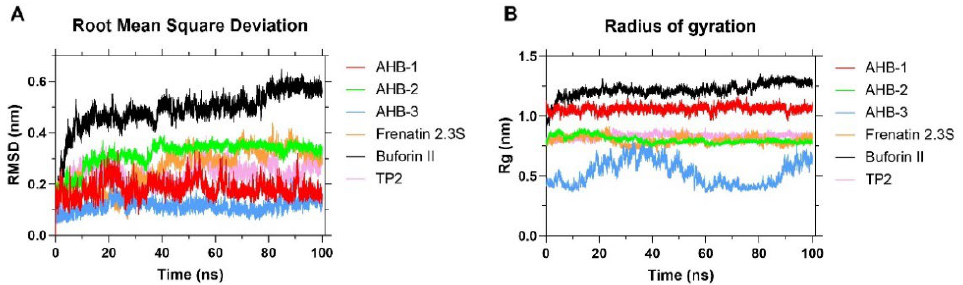
Figure 4. ( A ) Root Mean Square Deviation (RMSD) of the peptides’ carbon alpha structure as a function of time. ( B ) Radius of Gyration (Rg). Each MD simulation lasted for 100 ns.